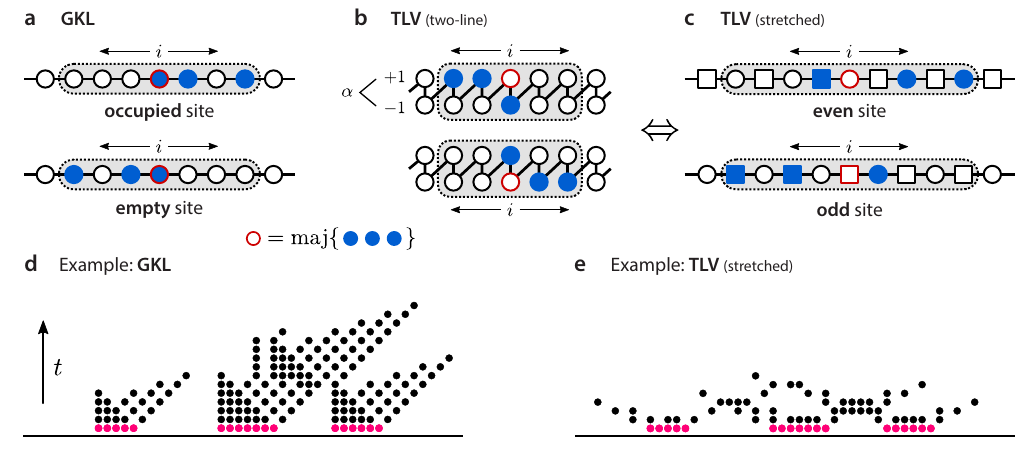
Figure 3: Two classical density classifiers. a The famous Gács-Kurdyumov-Levin (GKL) CA features R = 3-rules with a state-dependent choice for local majority voting. b The two-line voting (TLV) CA can be considered a symmetrized version of GKL that gets rid of the state- dependent majority vote by adding an additional bit per site. c In our case, the stretched version of TLV is more intuitive: Instead of adding new states, one adds new sites with different transition rules for even and odd positions. d Example evolution of a three-cluster state (red) under GKL transitions (time runs upwards). e Decoding of the same initial state under TLV transitions. Note the different messaging behavior of GKL (asymmetric) and TLV